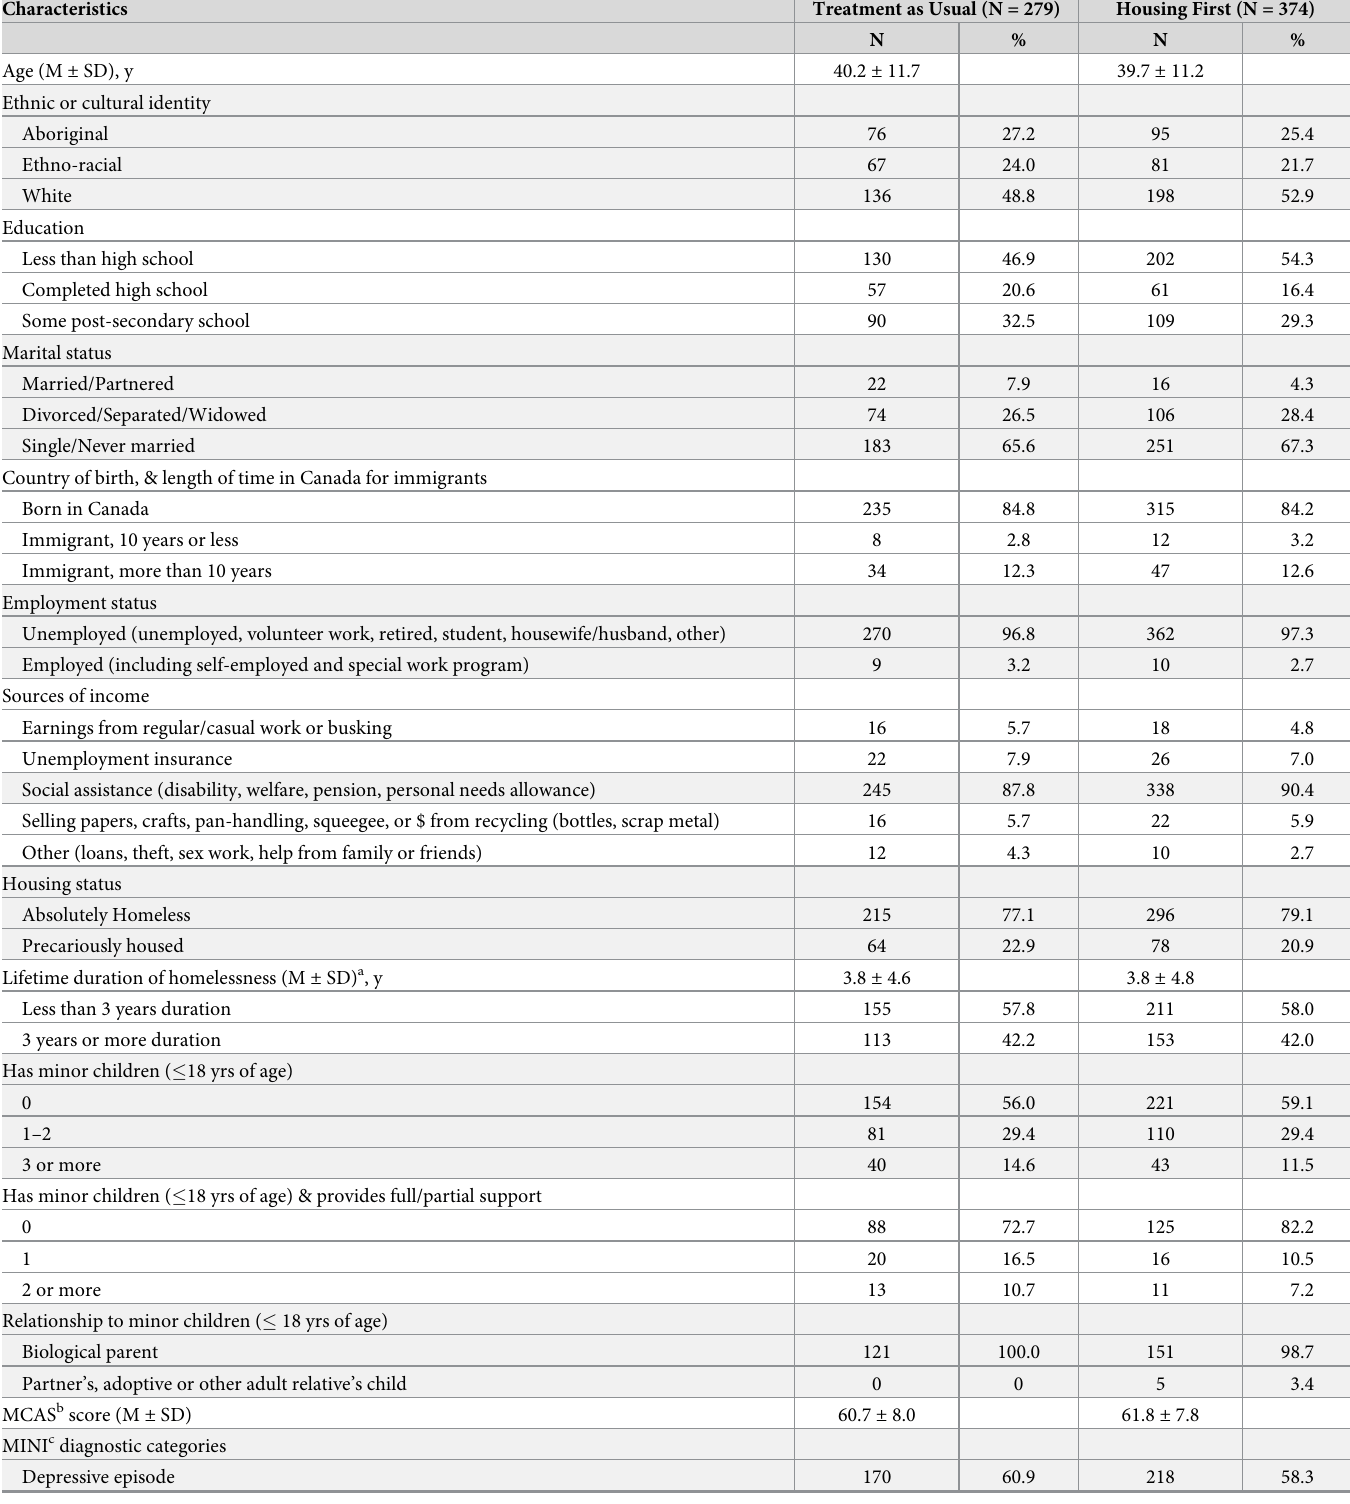
Table 1. Baseline characteristics of women participants in the Canadian At Home/Chez Soi study by randomization group ( N = 653).